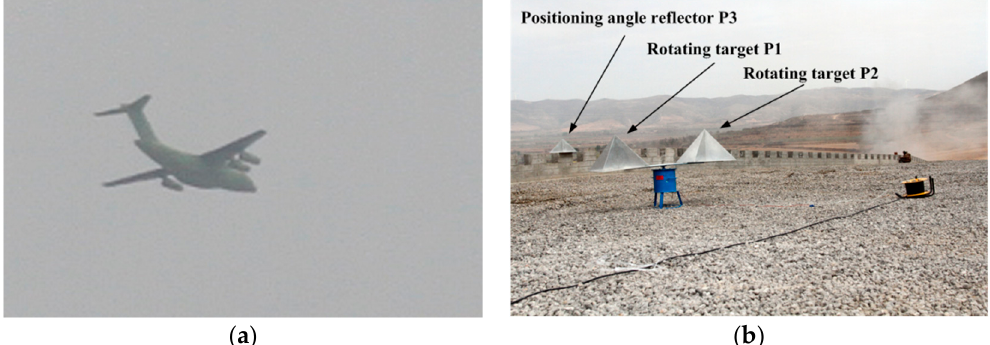
Sensors 2018 , 18 , x FOR PEER REVIEW Figure 12. On-site shooting. ( a ) Yun-8 aircraft; ( b ) Angle reflectors. Figure 12. On-site shooting. ( a ) Yun-8 aircraft; ( b ) Angle reflectors.